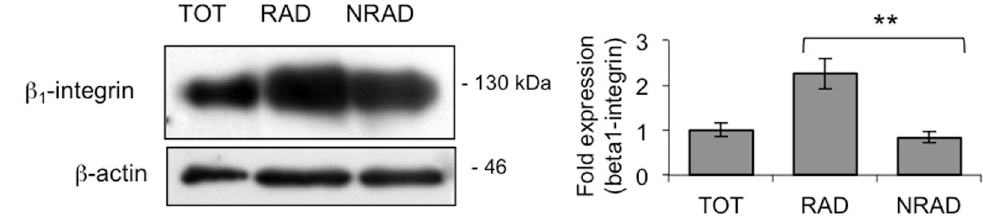
Figure 1. β -integrin levels in cSCC subpopulations. β 1 TOT cells were analyzed immediately after separation by Western blot. β -actin was used as loading control. Graph shows the average densitometry values normalized to actin, ** p < 0.01.